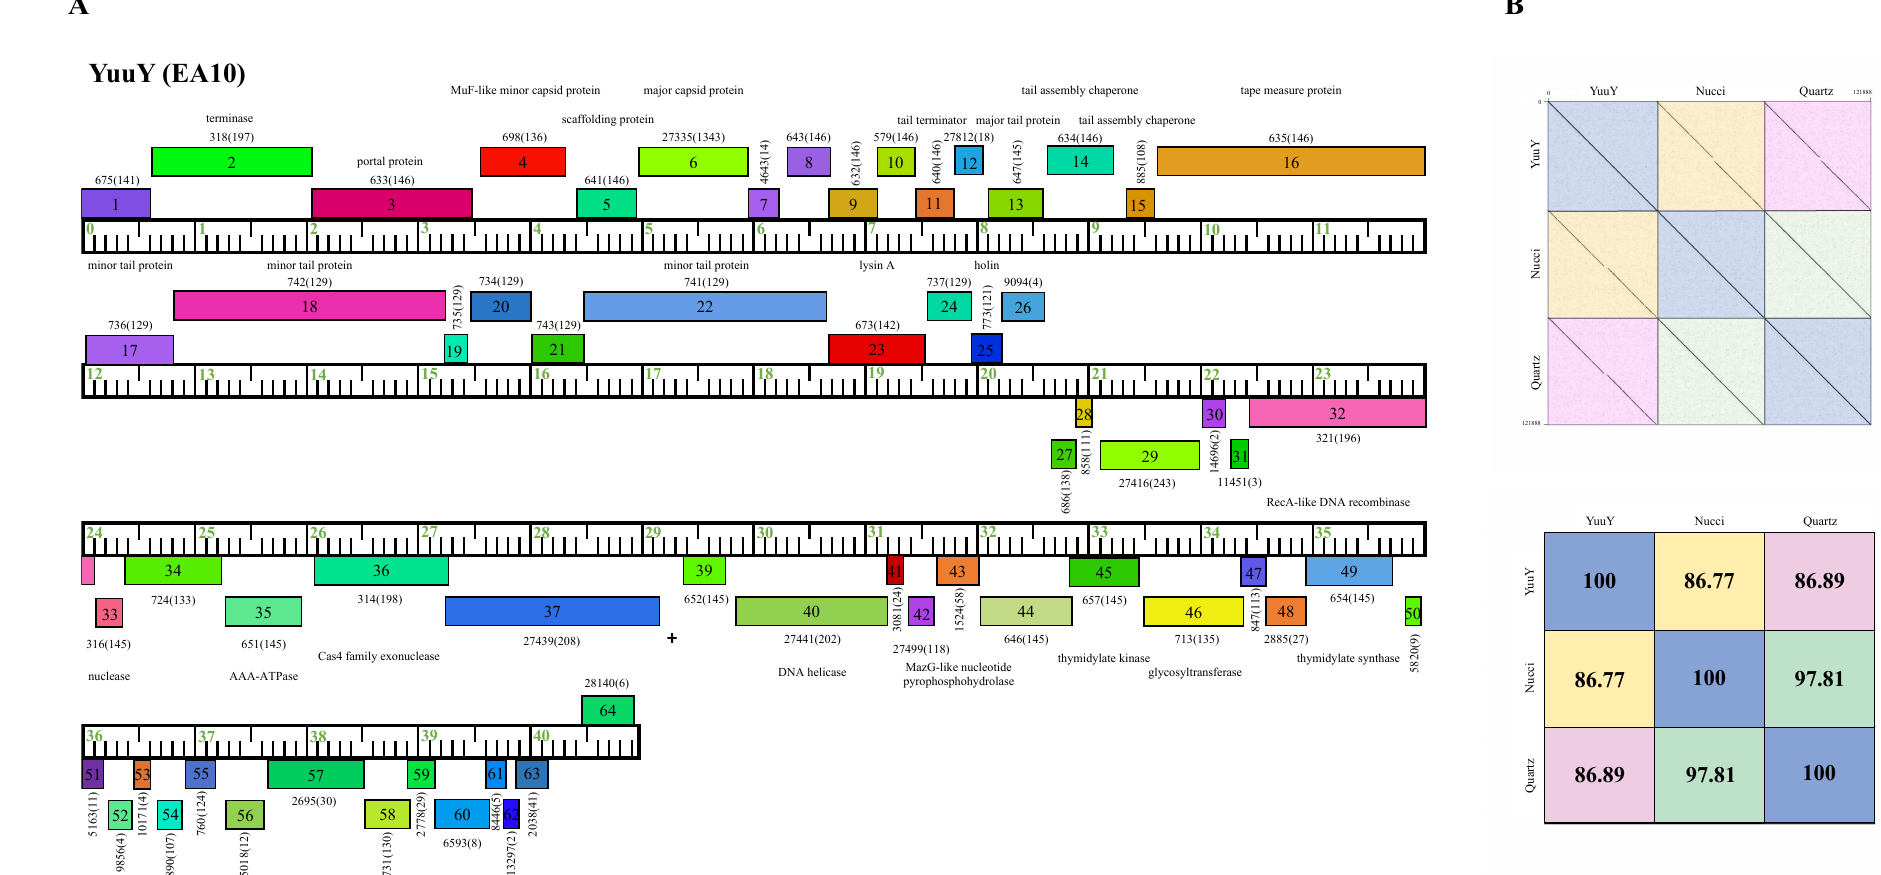
Figure 8. Genomic organization of Microbacterium Subcluster EA10 phage YuuY. ( A ) Whole genome organization of phage YuuY. Genes are represented as boxes above or below the genome, reflecting rightwards or leftwards-transcription, respectively. The phamily number, along with the number of members in the specific phamily in parentheses, are also written above or below the boxes. ( B ) Dot plot and percent identity comparisons of YuuY to two other Subcluster EA10 phages, Nucci and